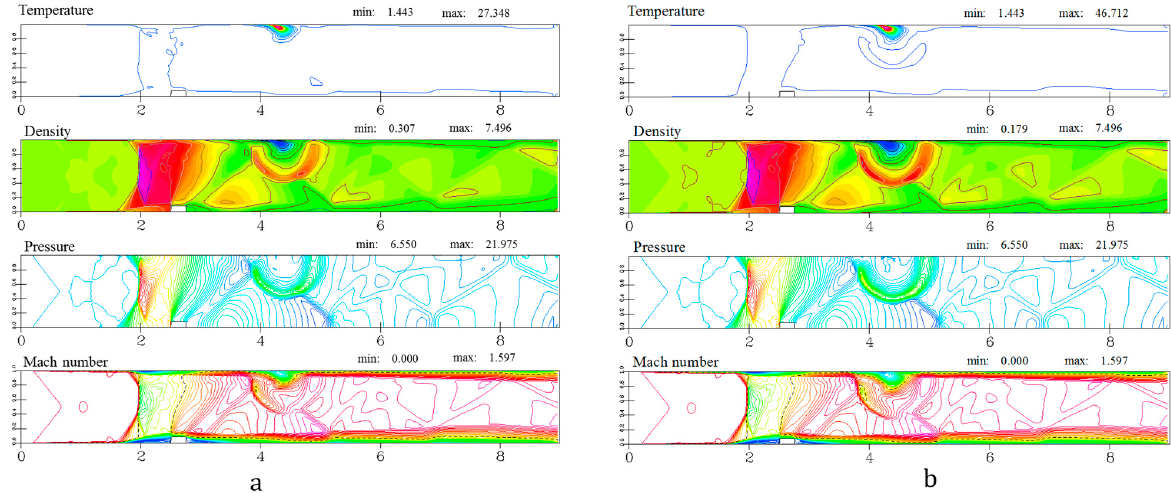
Figure 10. The simulated fields of dimensionless temperature, density, pressure, and local Mach number (from top to bottom) 16 µ s after the energy input: 0.22 J ( a ) and 0.29 J ( b ). The energy input volume is 60 mm 3 ; the total time of the energy input is 600 ns. The flow Mach number is 1.40. The zero-time corresponds to the beginning of energy input. The temperature is normalized to a temperature of 293 K and the pressure is normalized to an initial pressure of 8.3 × 10 3 Pa. Density is given in kg/m 3 .